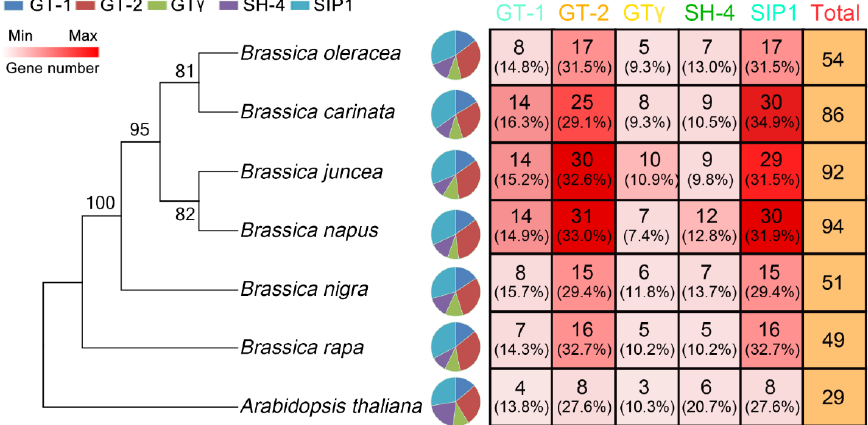
bers in each species are given in the table on the right. species are given in the table on the